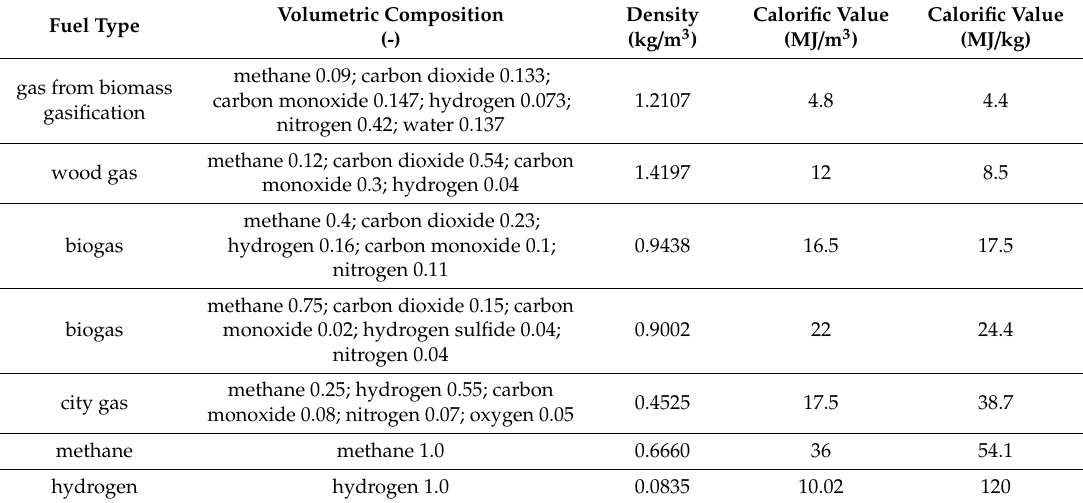
Table 2. The list of analyzed gases with di ff erent heating values